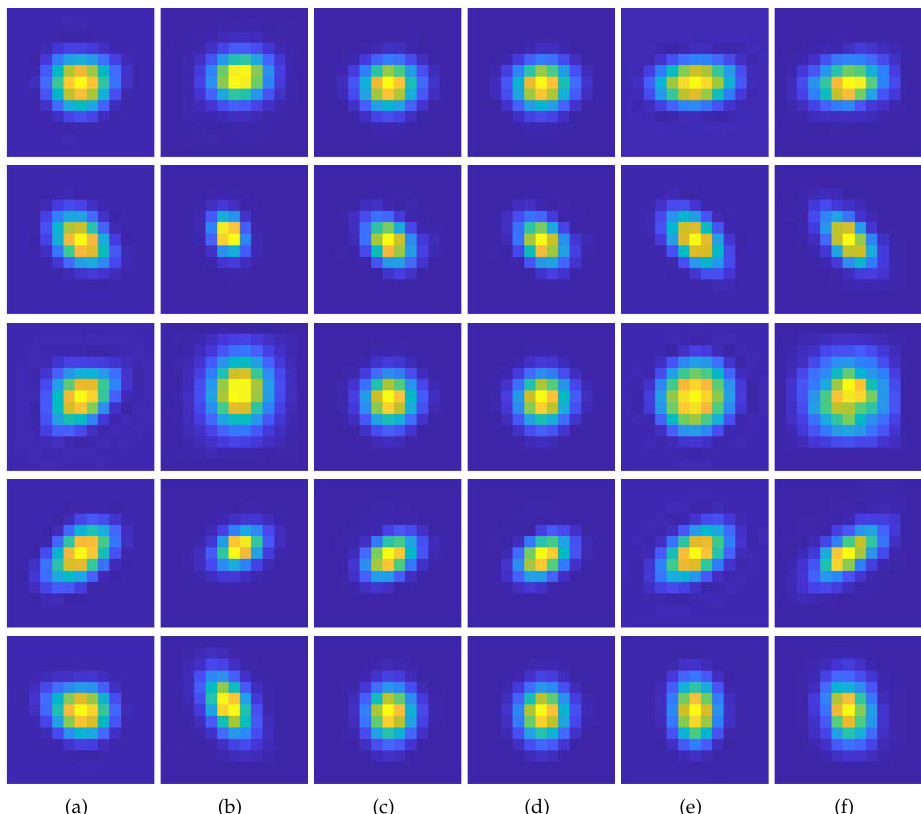
Figure 5. Qualitative results of the kernel estimation for scale factor of × 2 for DIV2KRK dataset. ( a ) KernelGAN [20], ( b ) FKP [21], ( c ) E-KernelGAN [22], ( d ) E-KernelGAN-DIP [22], ( e ) TVG- KernelGAN, ( f )